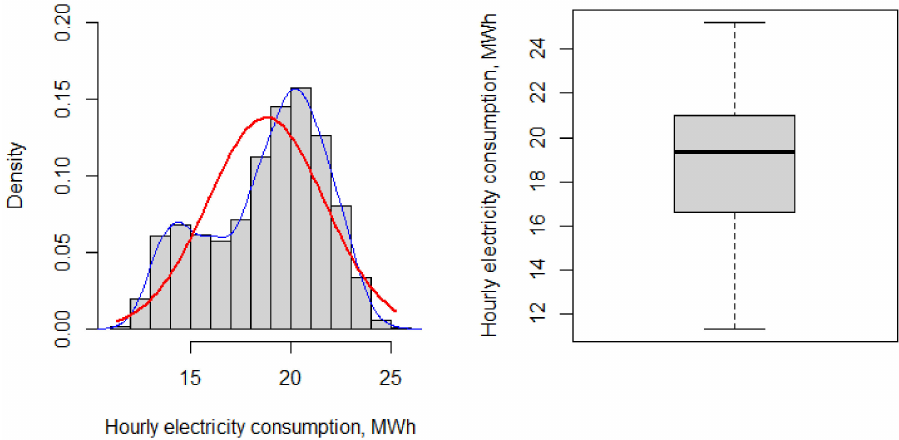
Figure 9. Graphical representation of the distribution of hourly electricity consumption for the M2 object. Source: own study in the RStudio environment.